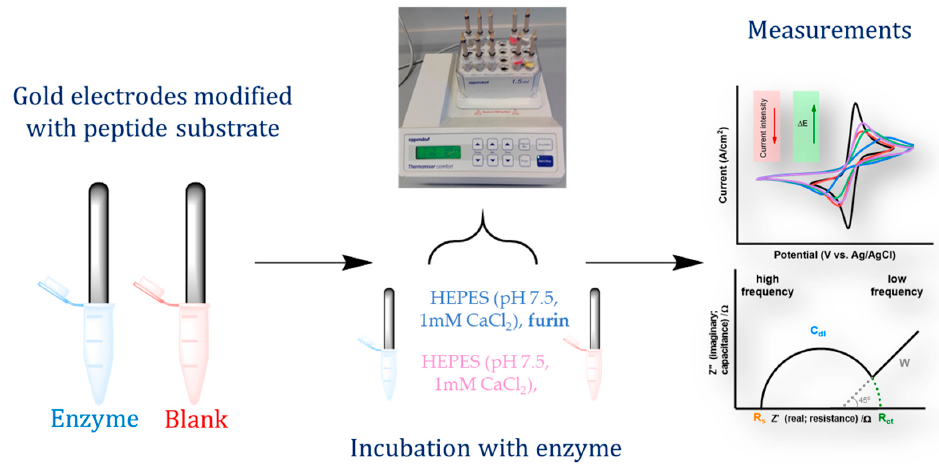
Figure 1. Schematic presentation of the new incubation method for electrochemical purposes.